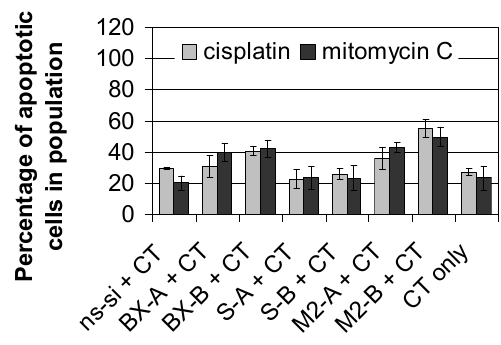
Figure 6. Apoptosis rate after treatment of J82 bladder cancer cells with siRNAs